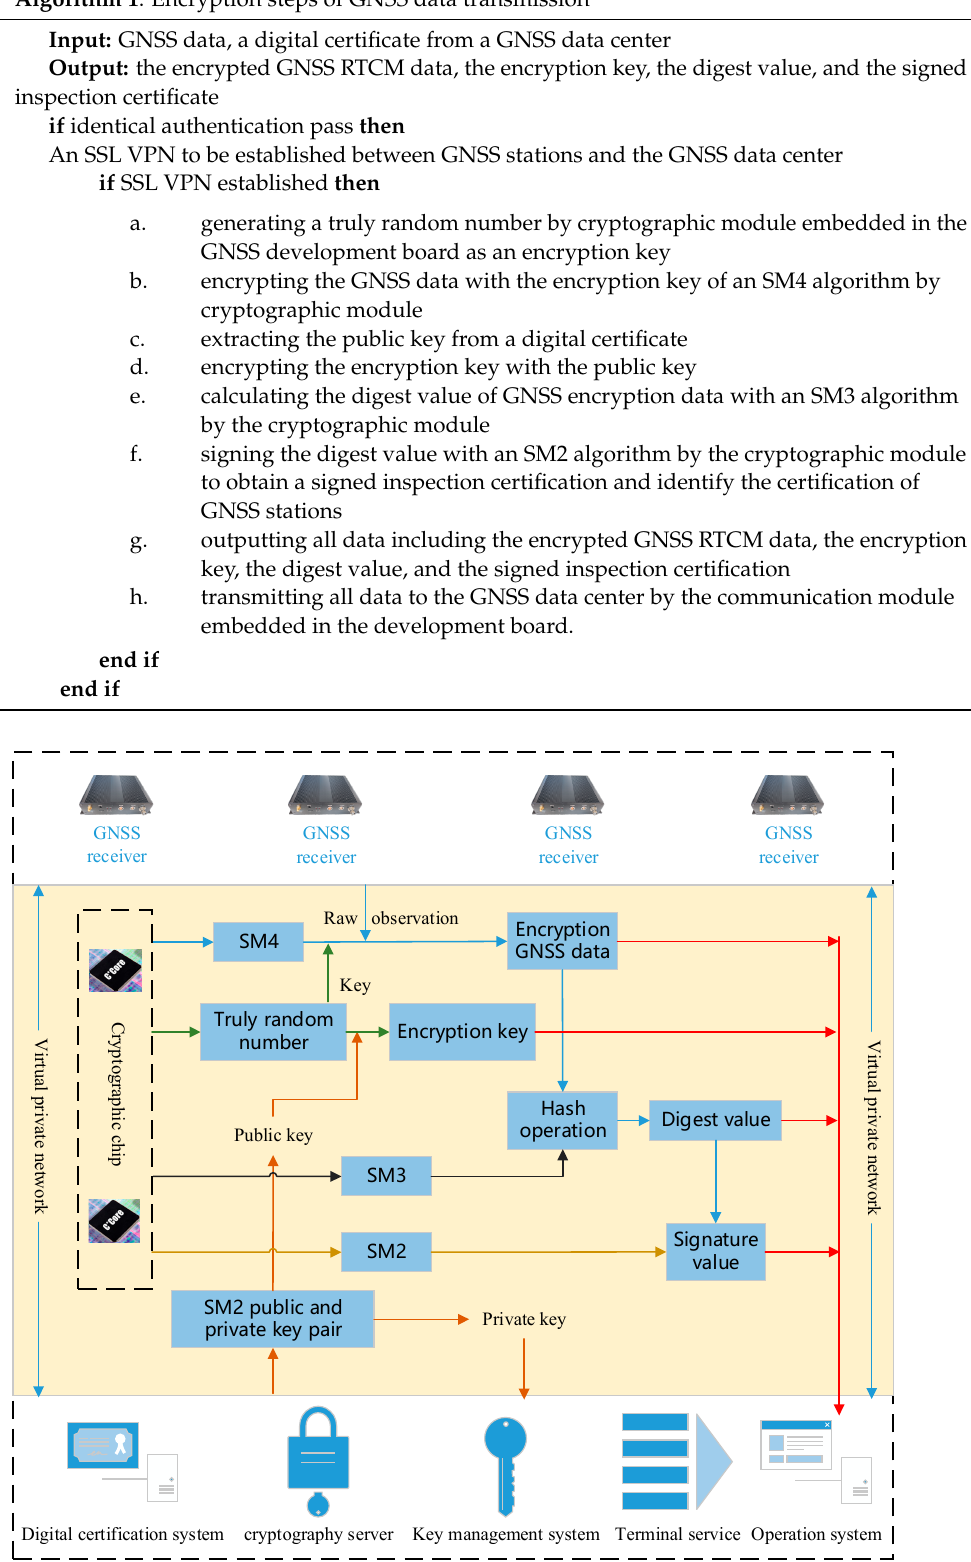
Figure 4. The flow chart of GNSS RTCM data encryption.